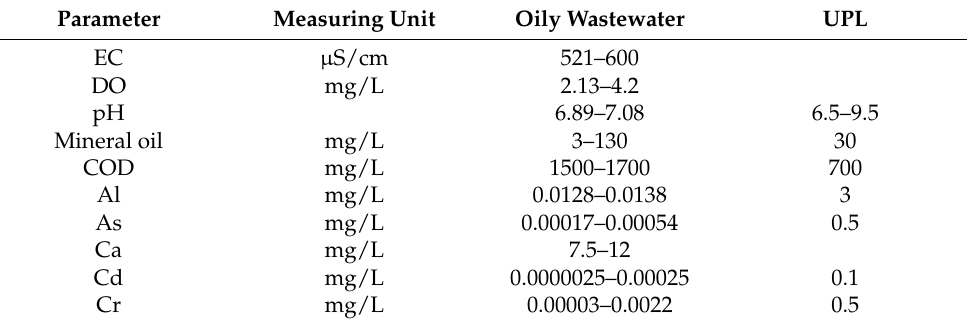
Table 2. Physico-chemical parameters of the sample of the oily raw wastewater and the upper permissible limit prescribed by Croatian regulatory body (UPL) for wastewater suitable for discharge into public sewer system